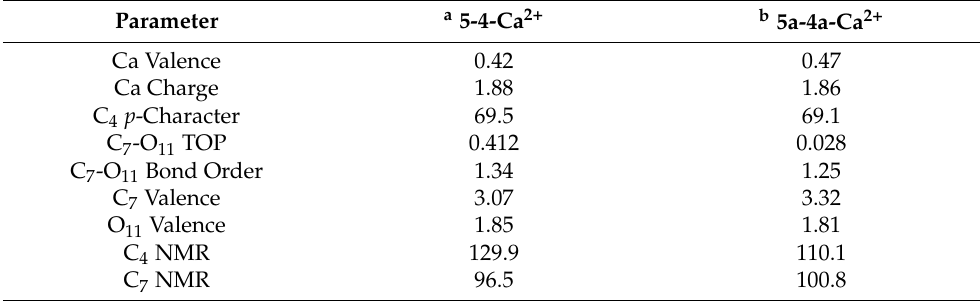
a The geometry in Figure 6d. b The geometry in Figure 6c.